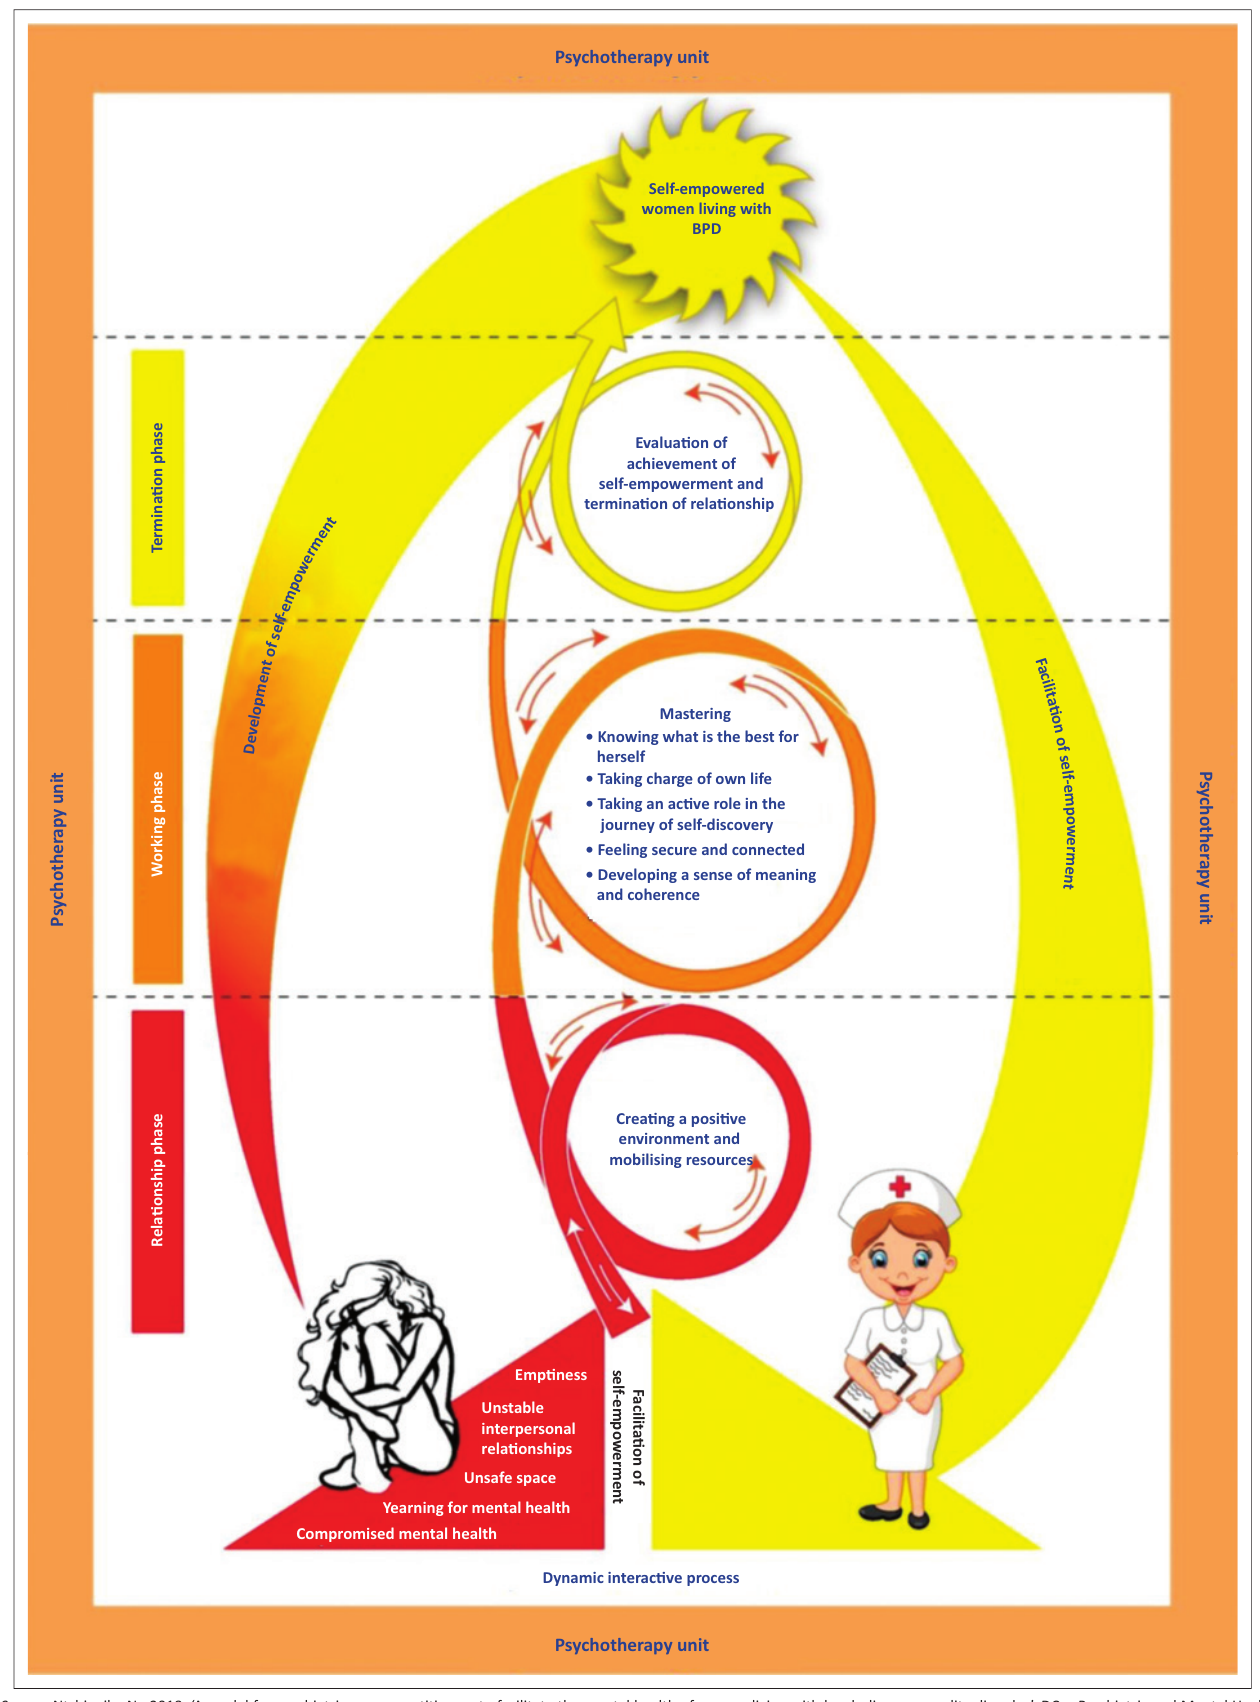
FIGURE 2: A model to facilitate self-empowerment of women living with borderline personality